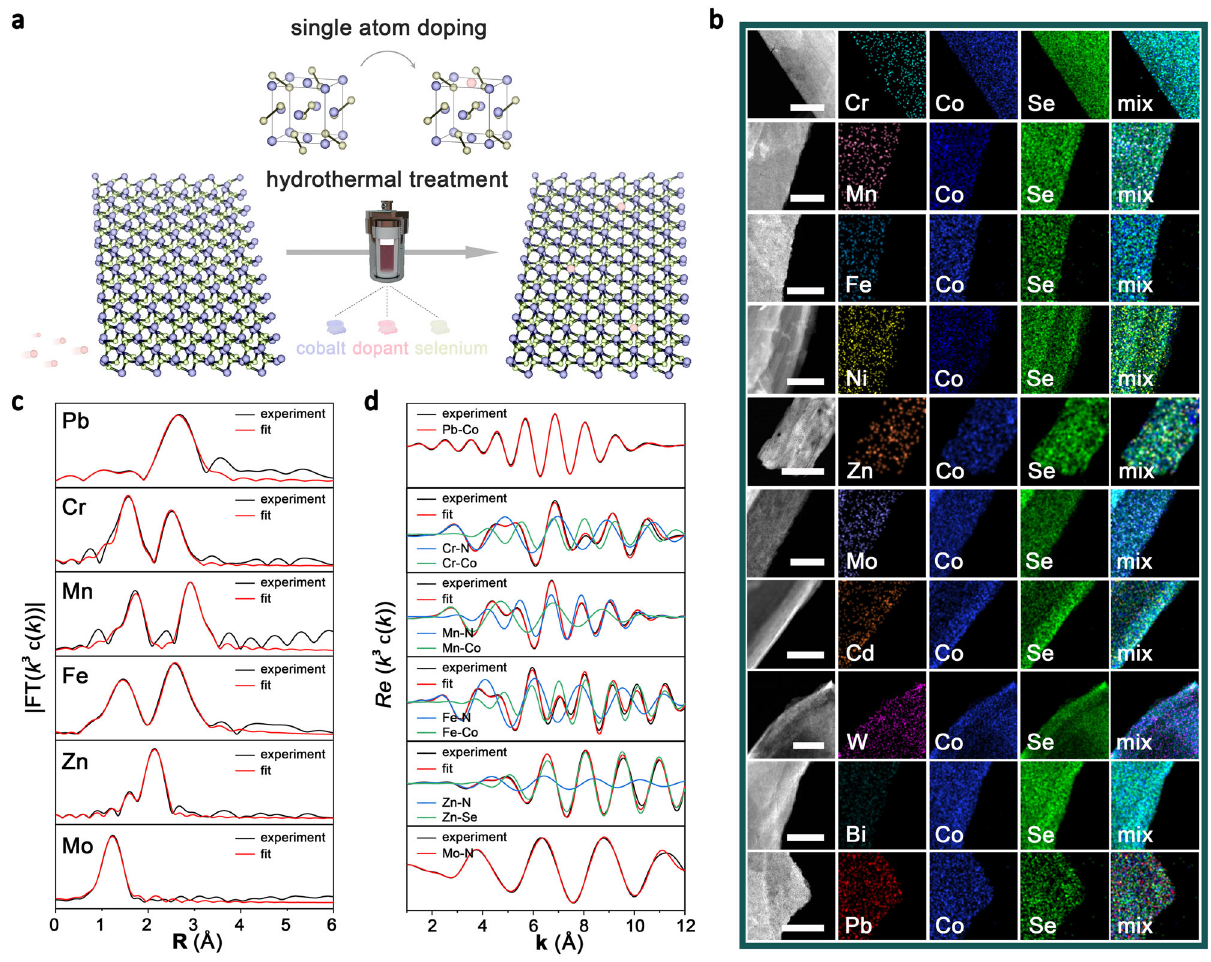
Fig. 2 | Synthesis and structural analysis. a Schematic illustration of the hydro- thermal synthesis of M-CoSe 2 -DETA. The balls in purple, green and pink represent Co, Se, and dopants, respectively. b STEM elemental mapping images of M-CoSe 2 -